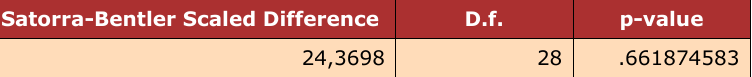
Table 13. Difference of adjusted Satorra-Bentler Chi Squared